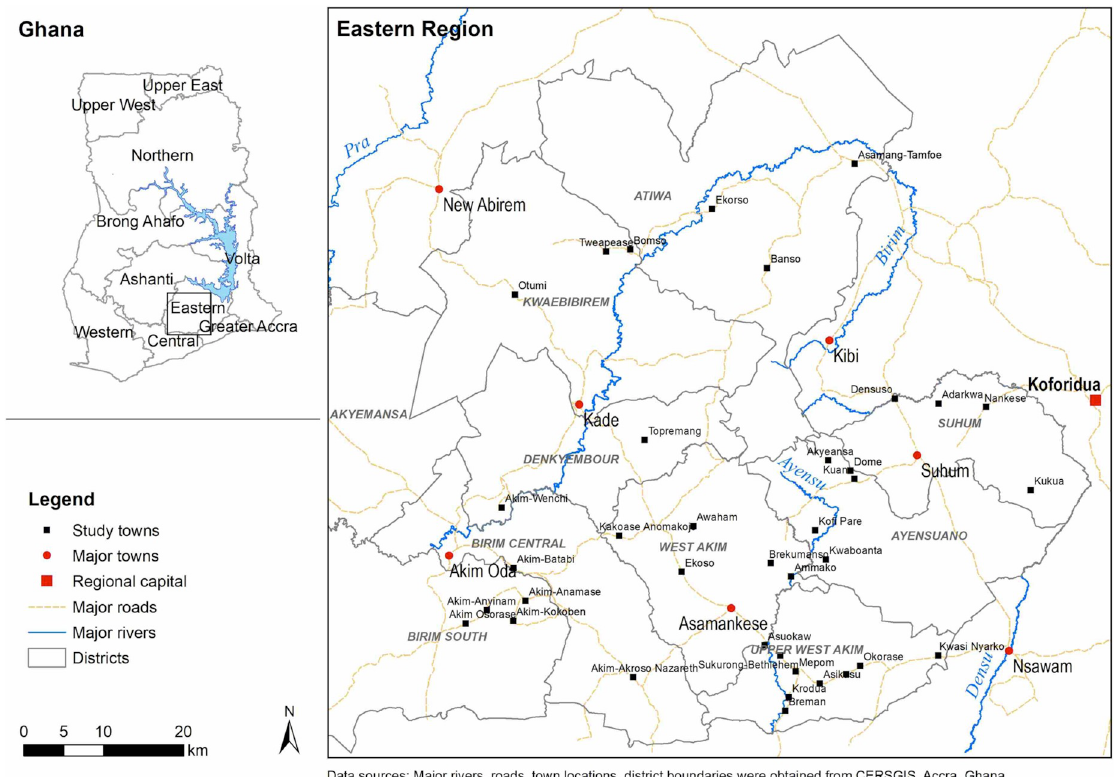
Fig 1. Map of the Eastern Region of Ghana showing study towns, other major towns, and the regional capital.